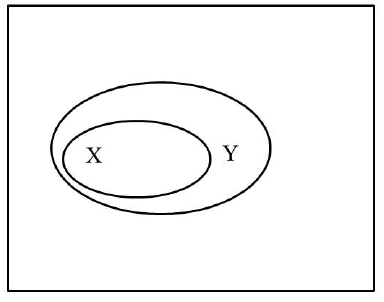
Fig. 3. Illustration of the rule (CONTRA) – and the rule (EX